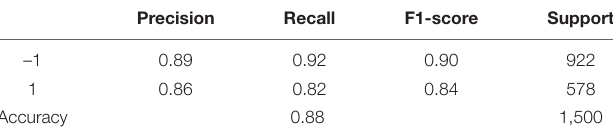
TABLE 4 | Fitting results.